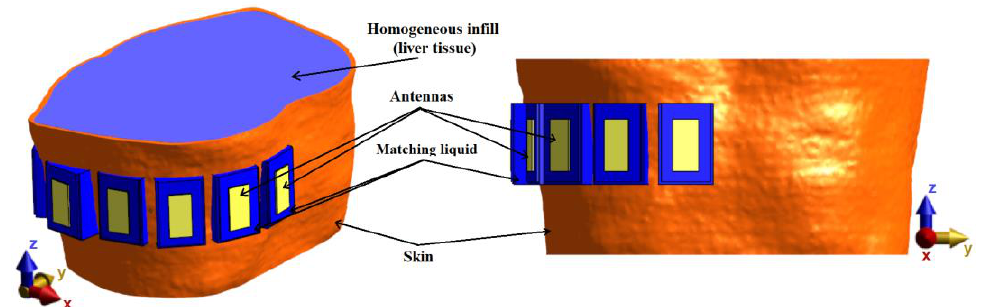
Figure 8. The homogeneous numerical model with a description of individual parts.